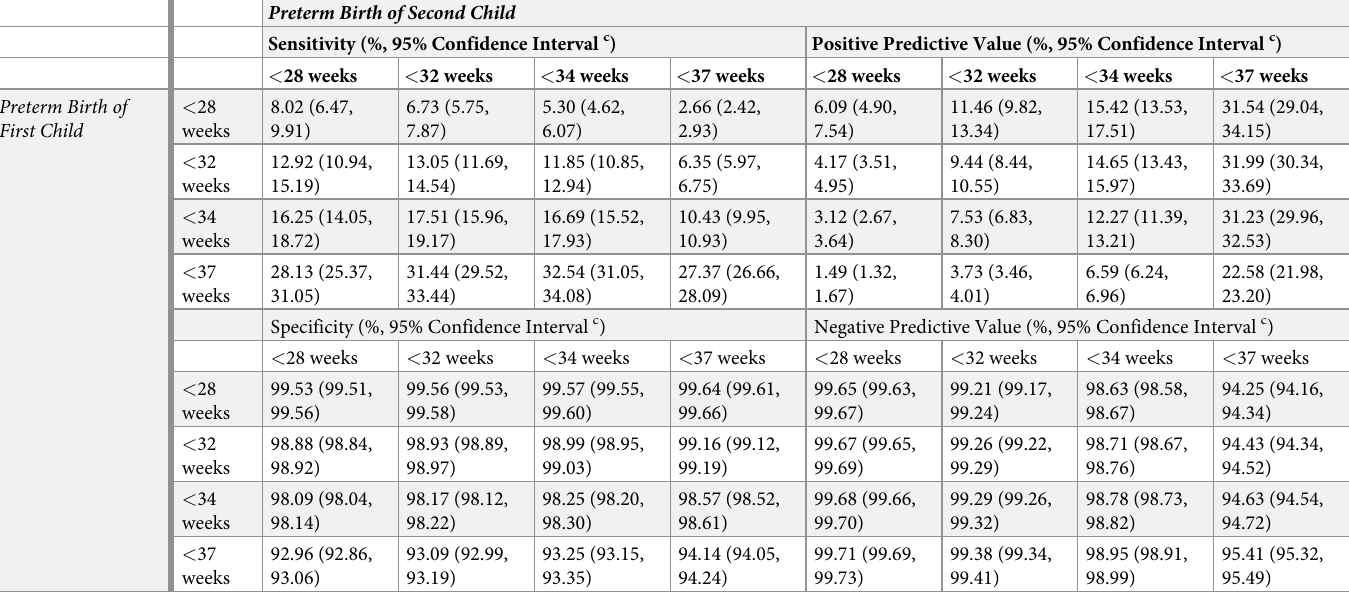
Table 3. Ability a of preterm birth b of the first child to predict preterm birth of the second child for the study population for mothers who gave birth to their first two singleton children between 1980 and 2015 in Western Australia (N = 255,151